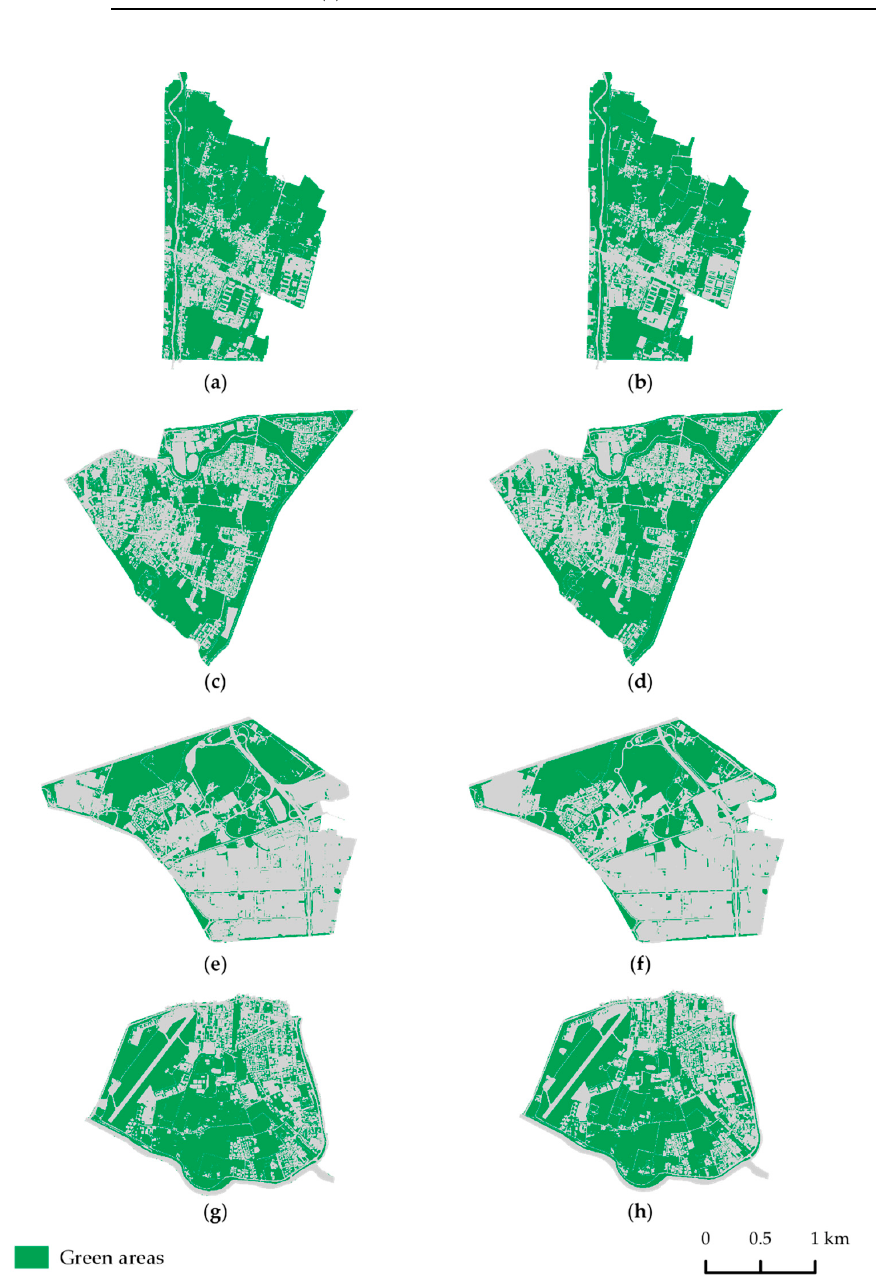
Figure 5. Comparison of green surfaces obtained from NDVI and from previous results in the four sample macro-areas [42,43]: ( a ) Brentelle neighbourhood resulted by NDVI analysis (macro-area 1); ( b ) Brentelle neighbourhood resulted by visual analysis (macro-area 1); ( c ) Forcellini neighbourhood resulted by NDVI analysis (macro-area 2); ( d ) Forcellini neighbourhood resulted by visual analysis (macro-area 2); ( e ) San Lazzaro neighbourhood resulted by NDVI analysis (macro-area 3); ( f ) San Lazzaro neighbourhood resulted by visual analysis (macro-area 3); ( g ) Basso Isonzo neighbourhood resulted by NDVI analysis (macro-area 4); ( h ) Basso Isonzo neighbourhood resulted by visual analysis (macro-area